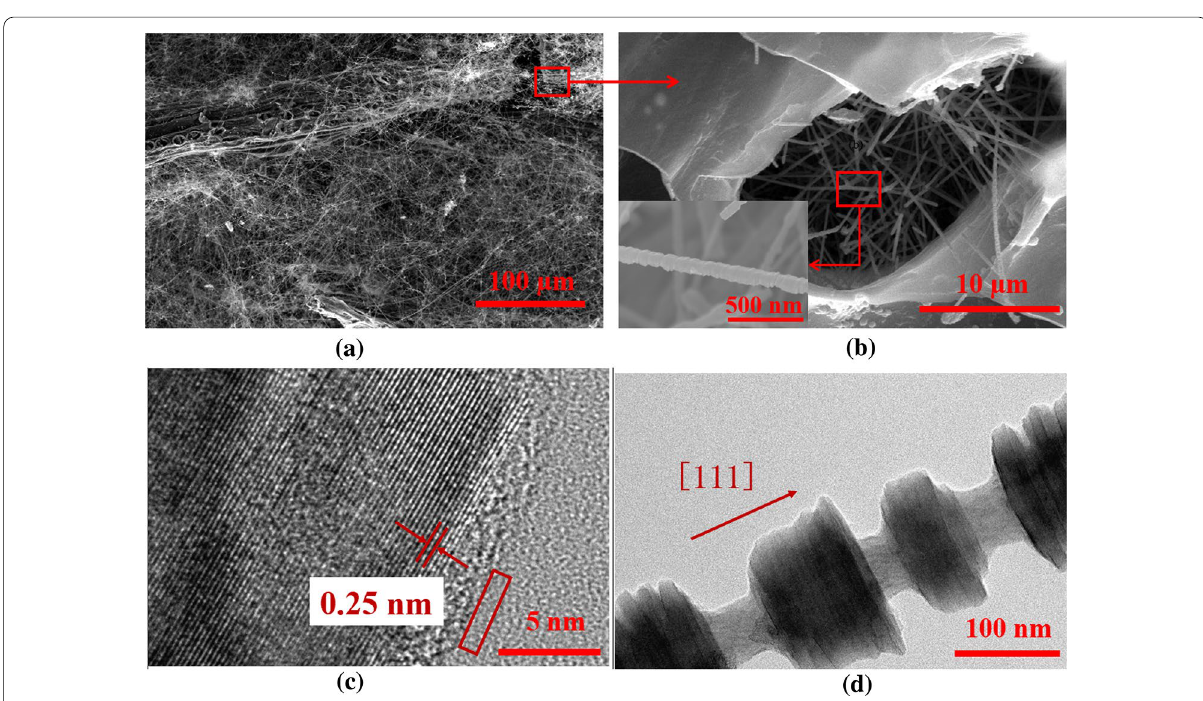
Fig. 6 a and b FESEM image and the corresponding EDX spectrum of SiC whisker; c and d TEM image of the R–SiC